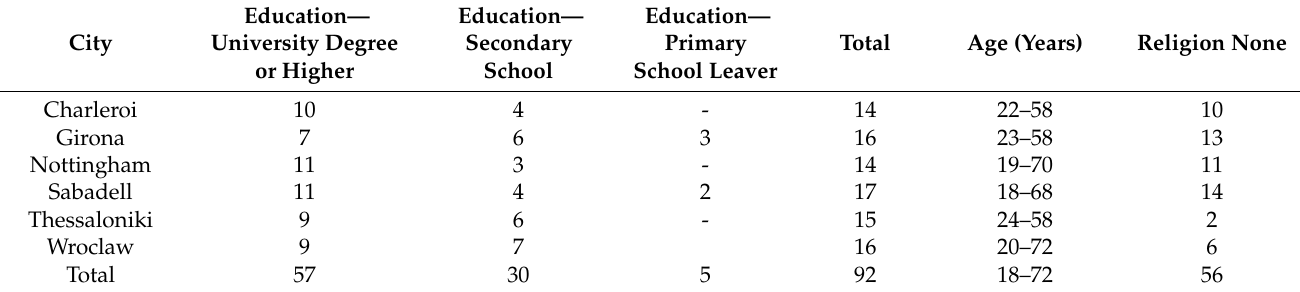
Table 2. Education level, age and religious affiliation of individual interviewees (Kofman et al.